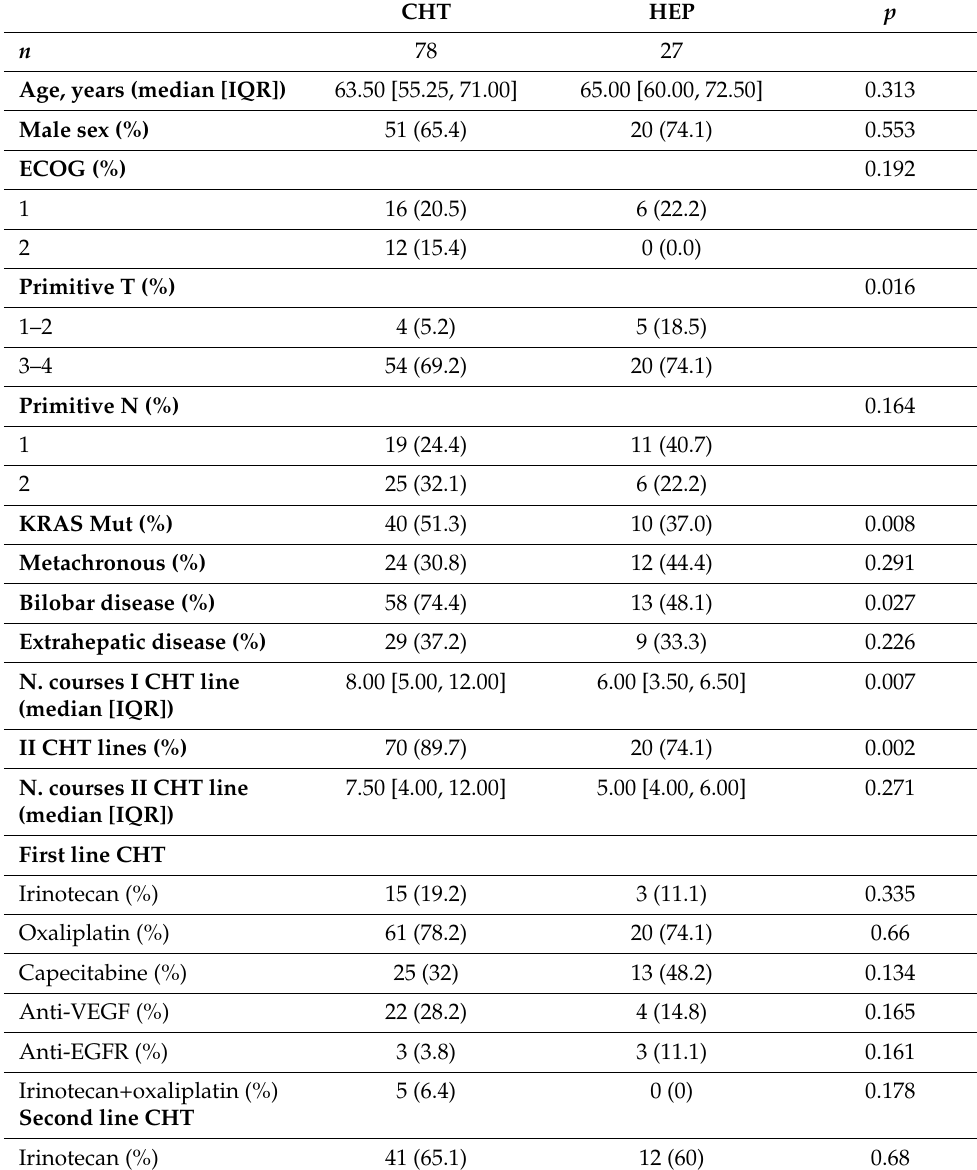
Table 1. Baseline characteristics of the cohort before